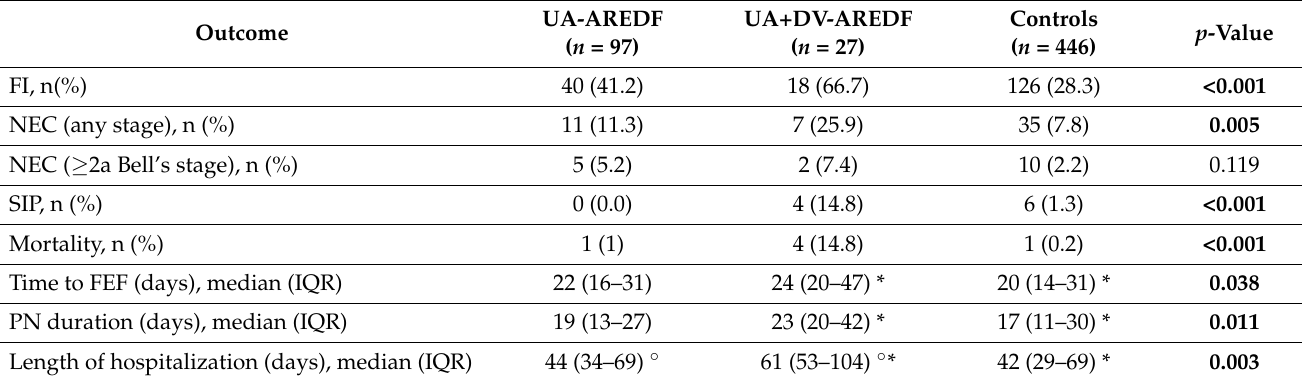
Table 2. Gastrointestinal and nutritional outcomes in infants with UA-AREDF, UA+DV-AREDF, and controls. Significant between-group comparisons are highlighted in bold. Abbreviations: FEF: full enteral feeding; FI: feeding intolerance; IQR: interquartile range; NEC: necrotizing enterocolitis; PN: parenteral nutrition; SIP: spontaneous intestinal perforation; UA-AREDF: absent or reversed end diastolic flow in the umbilical artery only; UA+DV-AREDF: absent or reversed end diastolic flow